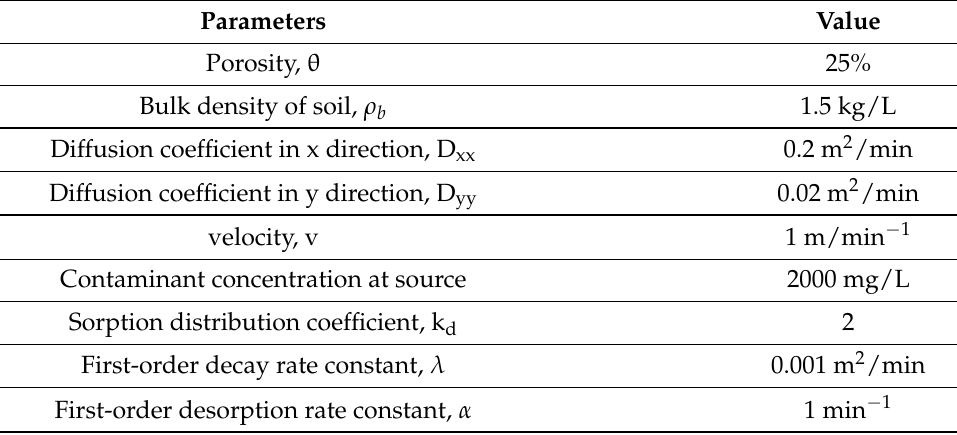
Table 2. The parameters values for analytical